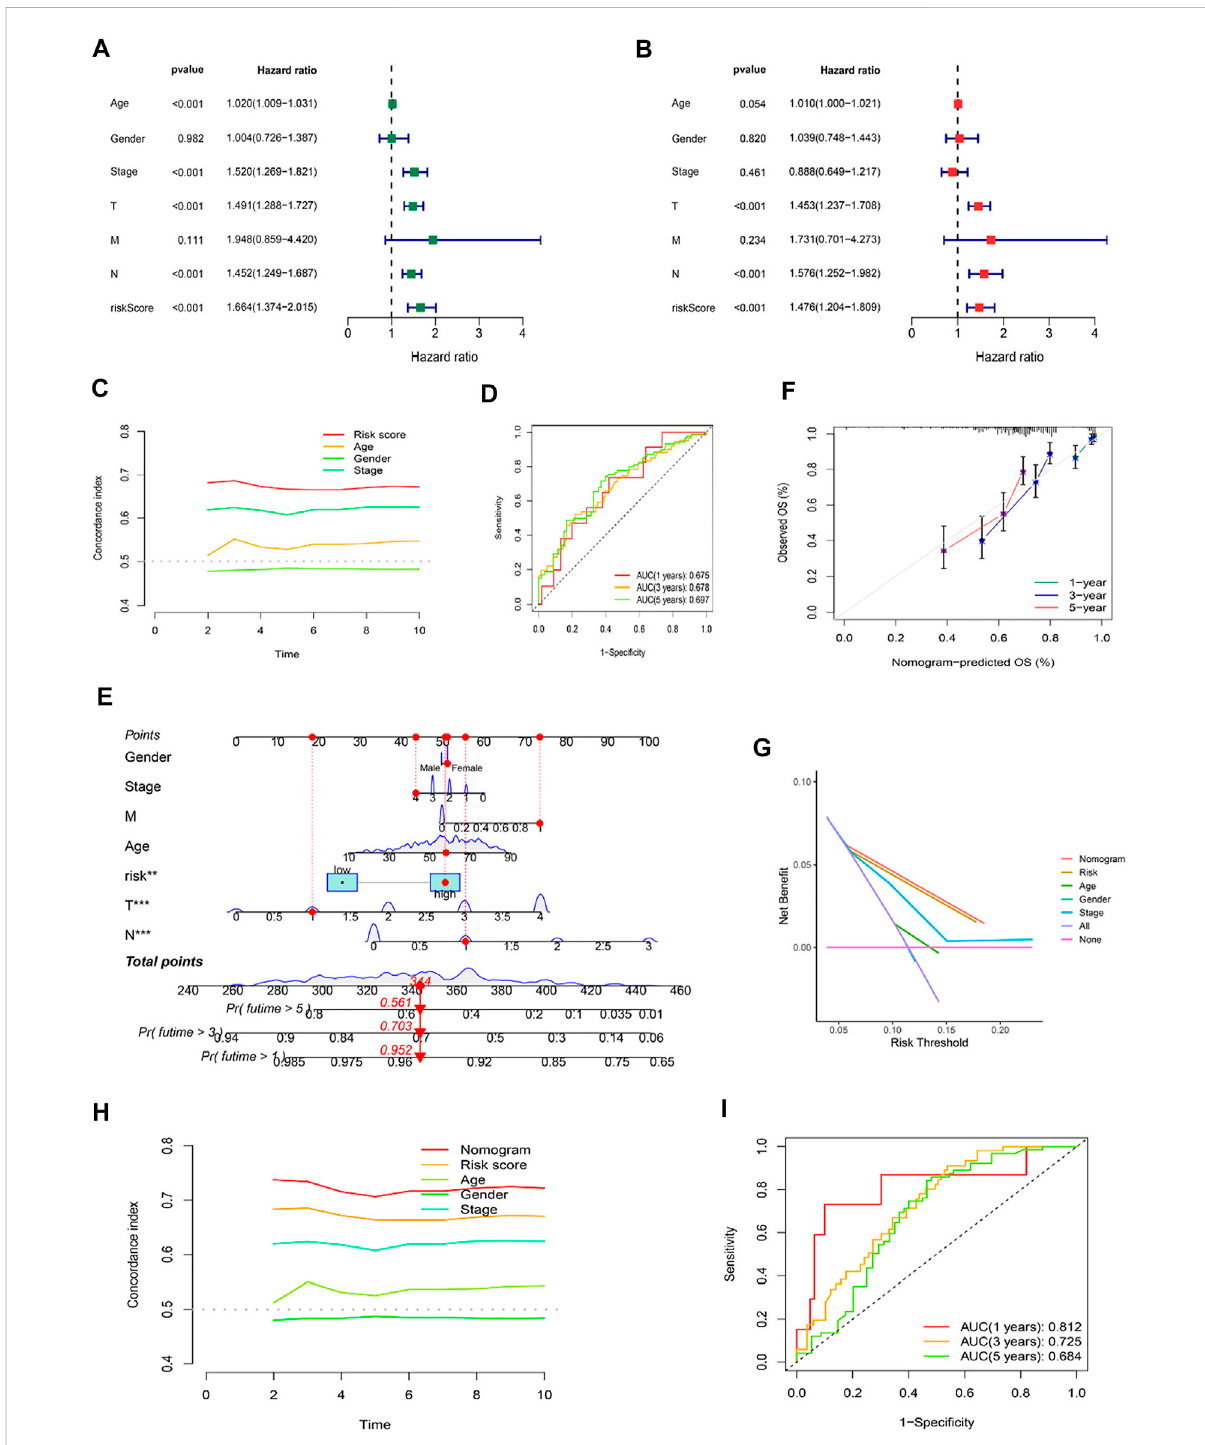
FIGURE 6 IndependentPrognosticFactorsandConstructionofNomogram.ForrestplotoftheunivariateCoxregressionanalysis (A) ,andmultivariateCox regressionanalysis (B) , based on theentire set. (C) The concordance indexof riskscore with clinical characteristics. (D) ROC curves for 1-, 3-, and 5- years OS in the risk model. (E) The nomogram. (F) The calibration curves of the nomogram predict the probability of the OS (The x-axis shows nomogram-predicted survival, and the y-axis shows actual survival. The grey line shows the ideal calibration line, and the color line represents the model-predicted calibration line. (G) The DCA curves of the nomogram. (H) The concordance index of nomogram, risk score and clinical characteristics. (I) ROC curves for 1-, 3-, and 5-years OS in the